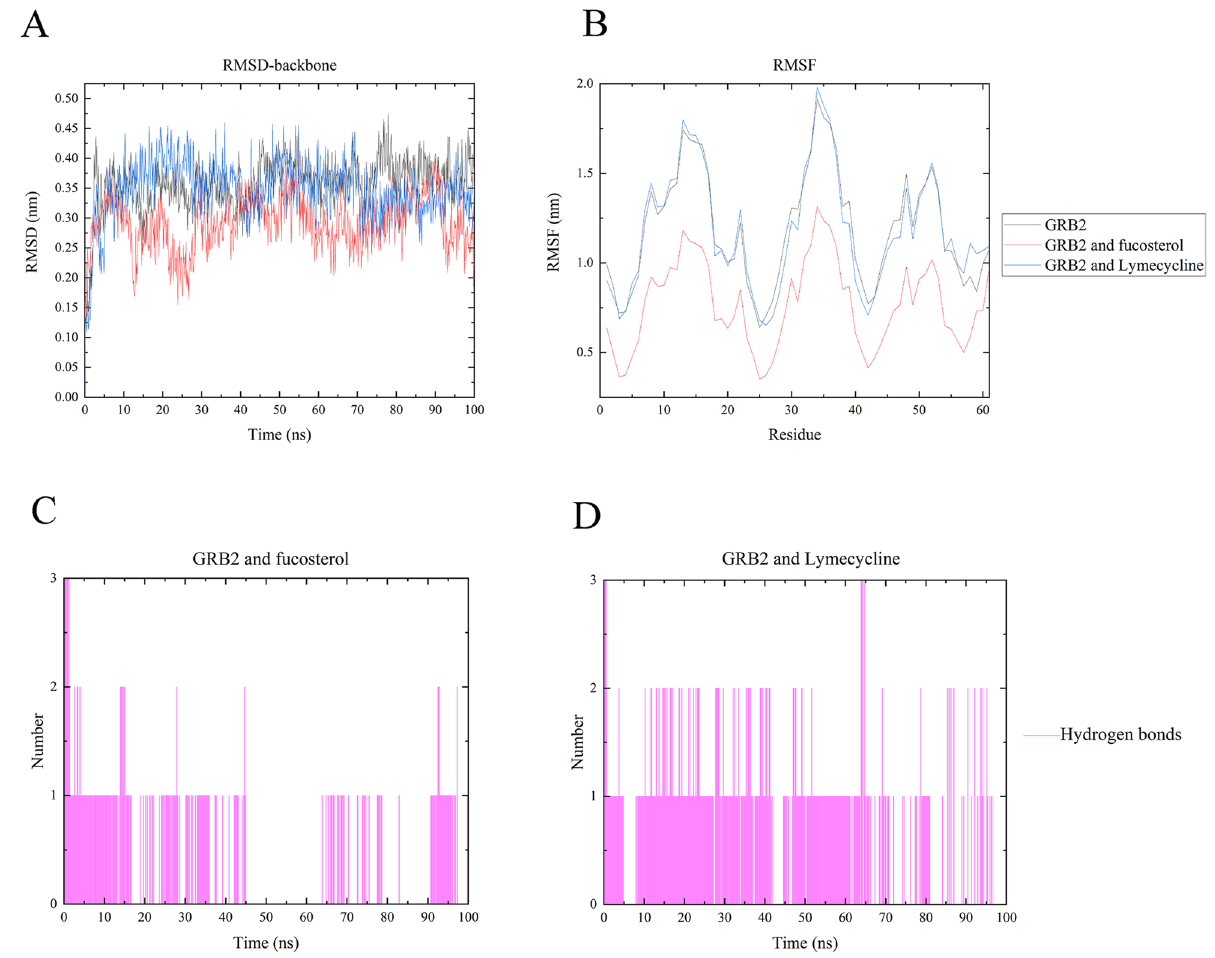
Figure 10. MD simulation interaction diagrams for 100 ns trajectory showing RMSD, RMSF and Hydrogen bond analysis. ( A ) Root mean square deviation (RMSD) of the 100 ns trajectories. ( B ) Root mean square fluctuations (RMSF) of the 100 ns trajectories. ( C ) Hydrogen bond analysis of fucosterol with GRB2. ( D ) Hydrogen bond analysis of Lymecycline with GRB2. The red polyline is shown as GRB2 and fucosterol, the black polyline is shown as GRB2, and the blue polyline is shown as GRB2 and lymecycline. ( A – D ) were obtained from Origin2019b (https ://www.origi